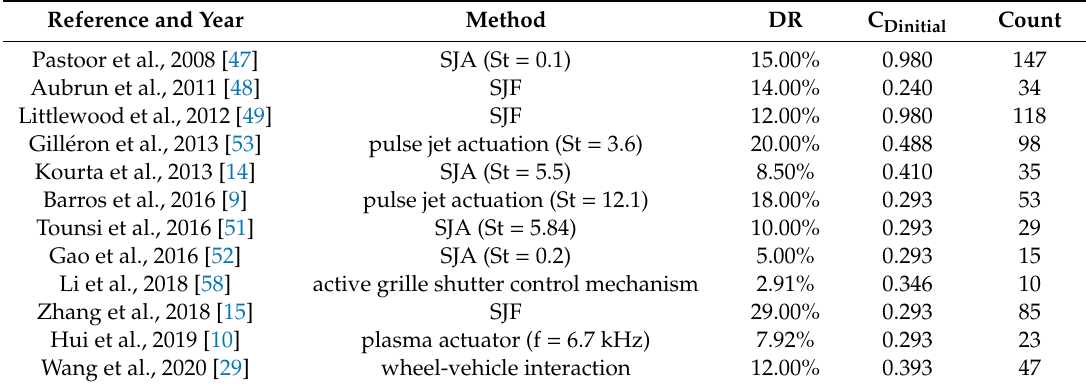
Table 1. Maximum DR by active systems.